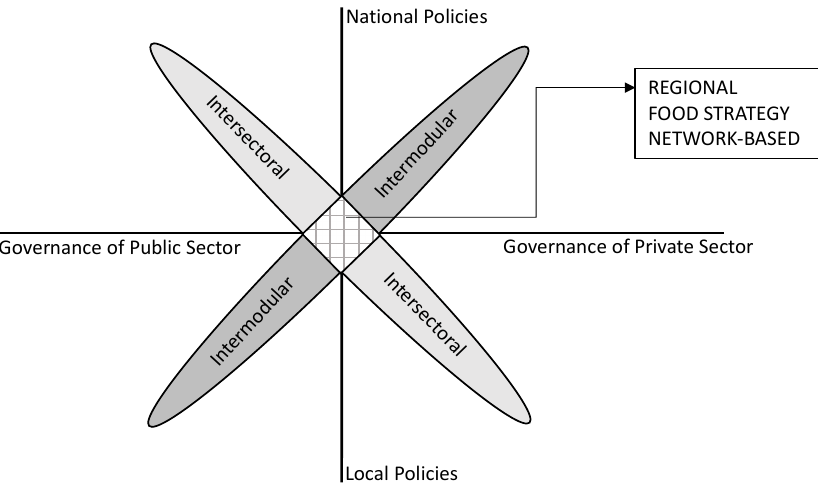
Figure 3. Conceptual model for the definition of the food strategy in the LMA.